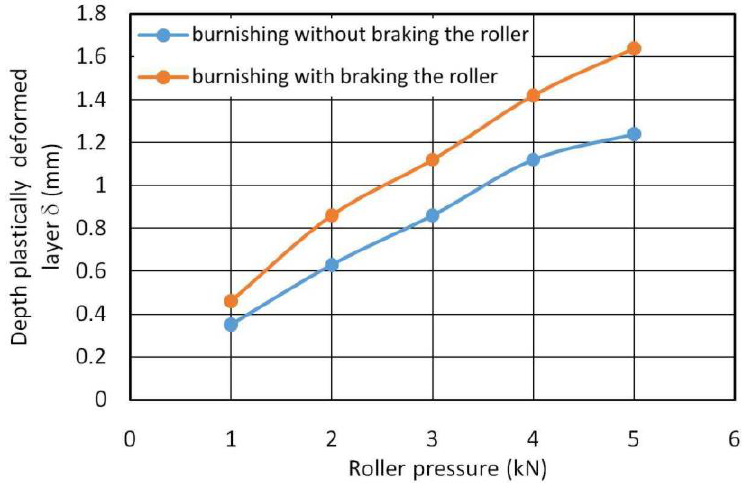
Figure 11. Effect of roller pressure on the depth of the plastically deformed layer for burnishing with and without braking applied to the roller.